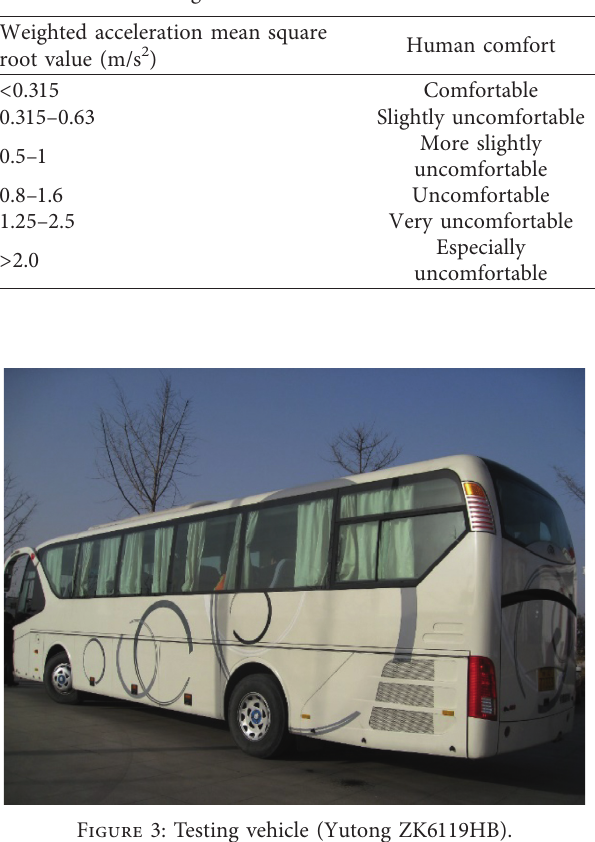
Table 1: Relationship between weighted acceleration mean square root value and driving comfort.